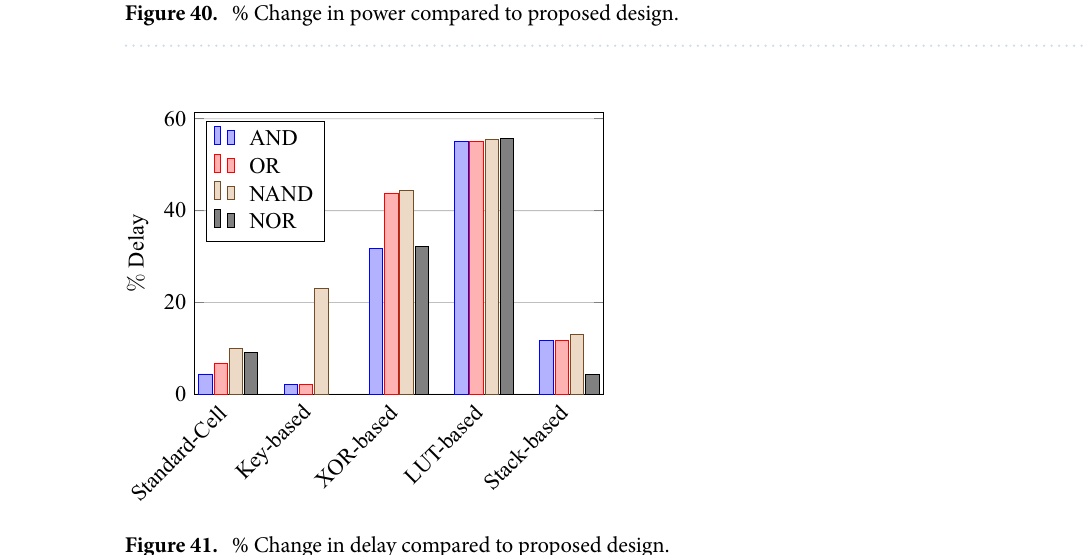
Figure 41. % Change in delay compared to proposed design.